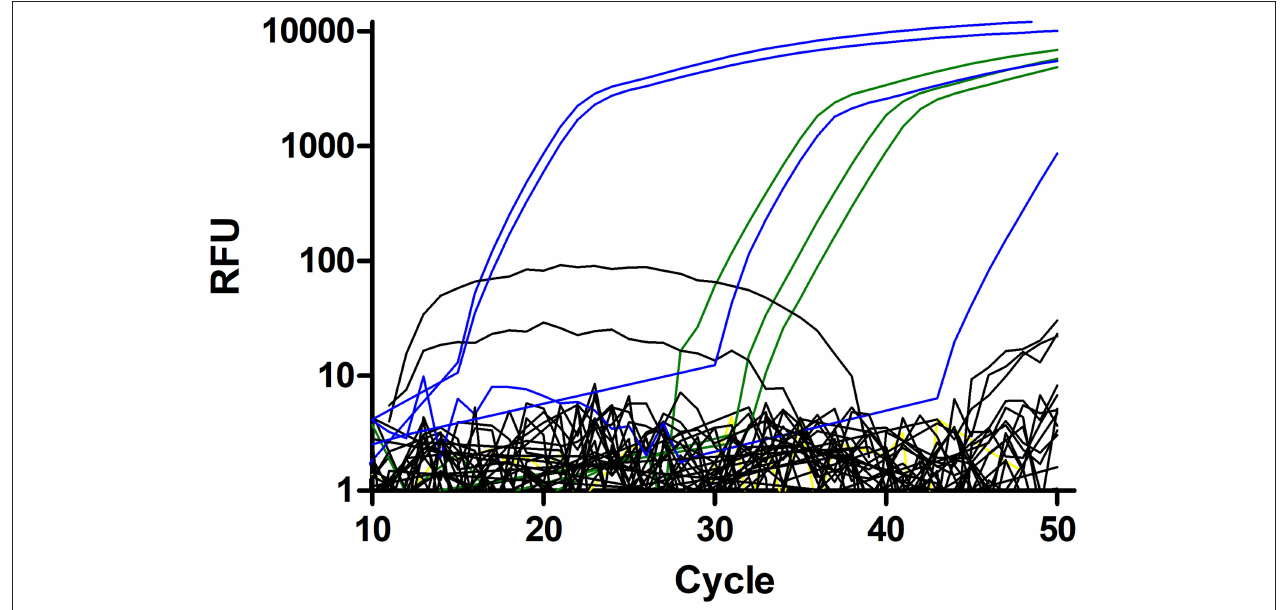
FIGURE 2 | Amplification plots for the Strongylus vulgaris real-time PCR. Plasmid DNAs with 500, 50, and 5 copies were used as positive control (green). The single negative control is shown in yellow but mostly hidden by the black curves. Field samples considered to be negative are shown in black and samples scored as positive are in blue. All positive samples, including the one with a very high Cq value were repeatedly tested positive and identity of all PCR products was confirmed by Sanger